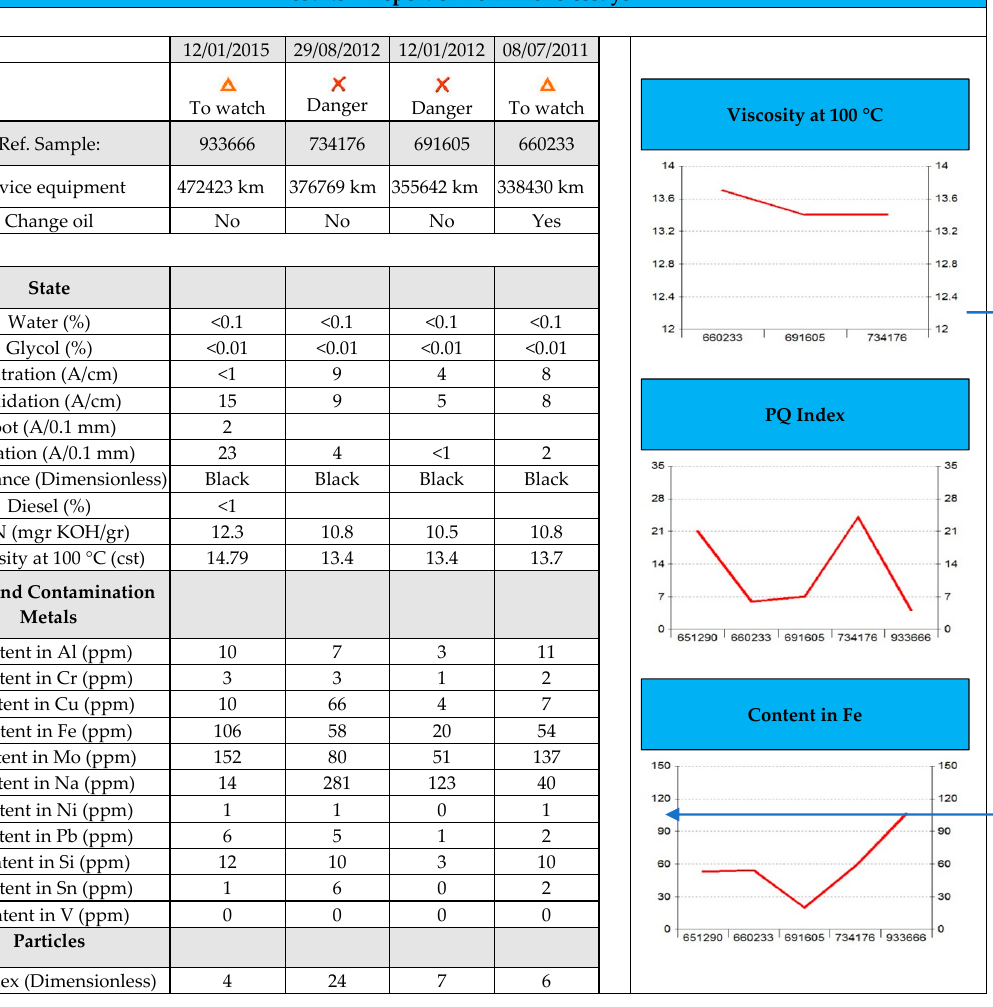
Figure 1. Oil analysis results report-Bus.